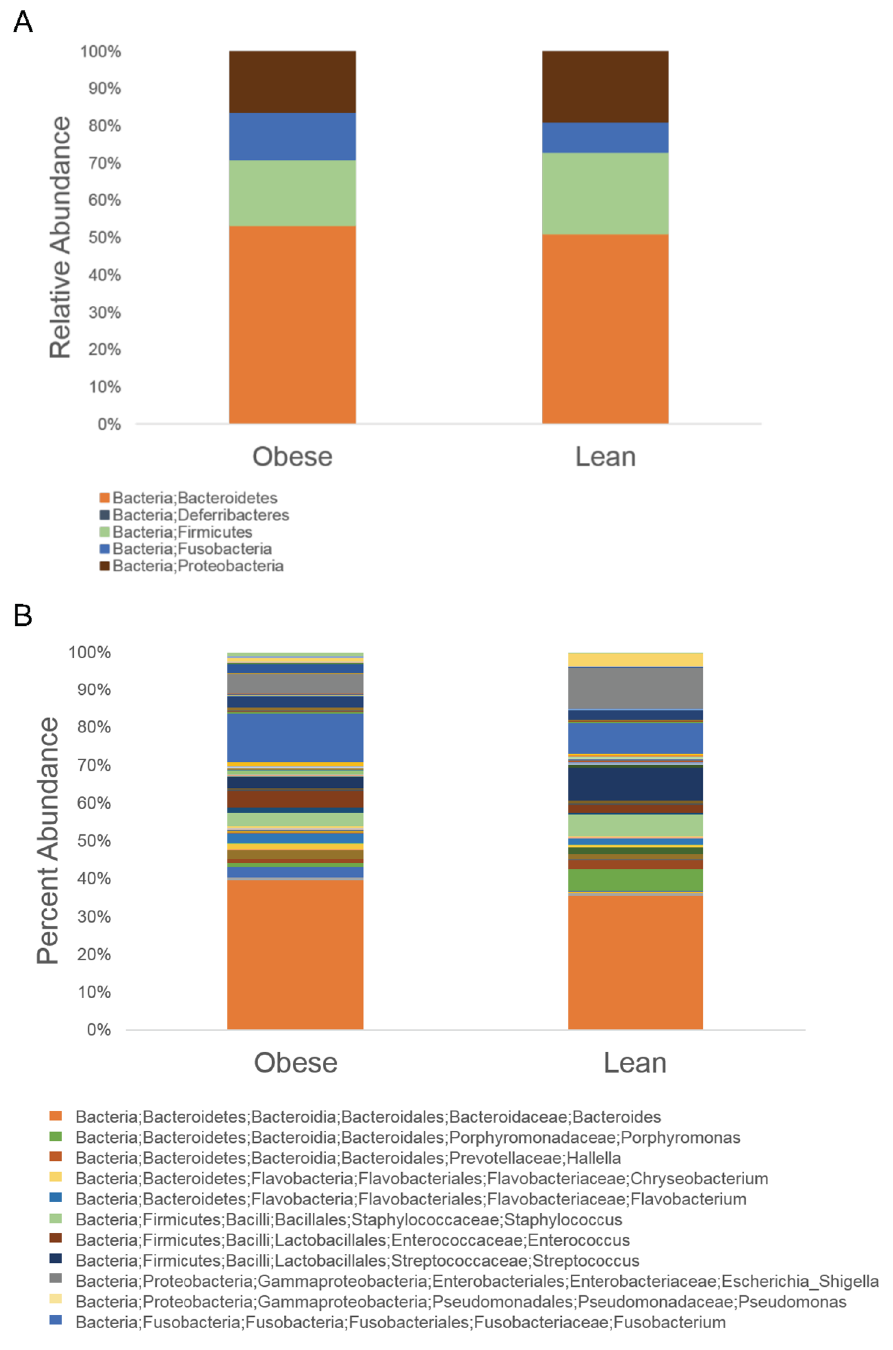
Fig 5. Taxon summaryof relative abundance within urogenital microbial communities of control and obese pigs shown as an averageof all animals from each treatment group. Taxa with the highest abundance is presented in the key. (A) Phylum-level relative abundance. (B) Genus-levelrelativeabundance.